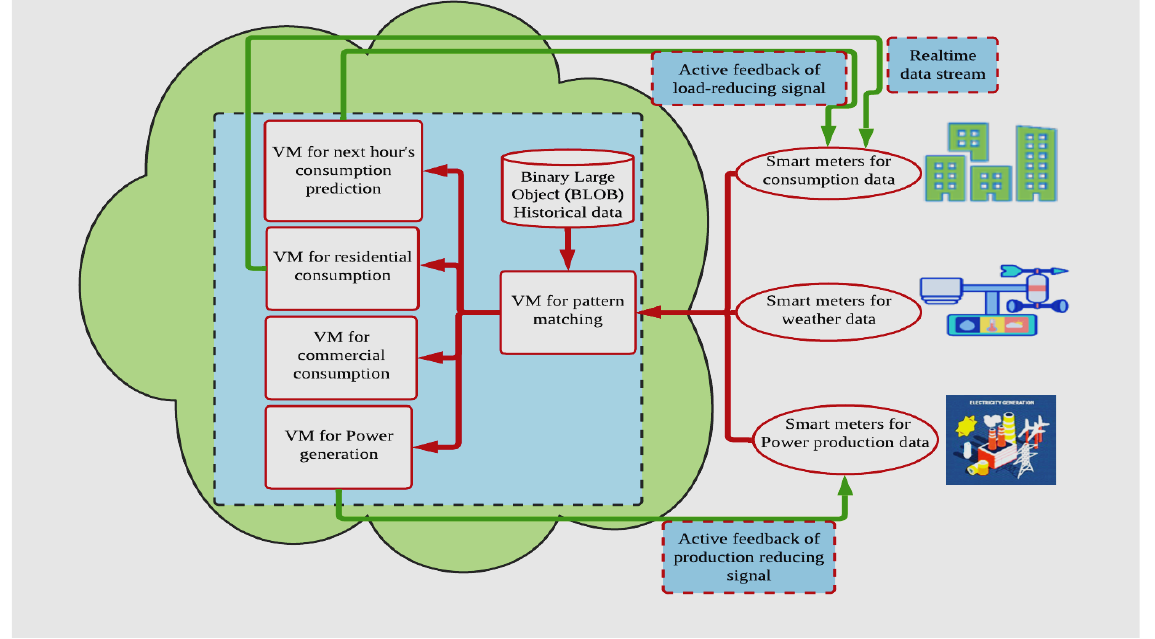
Figure 1. Efficient data processing for the power system.